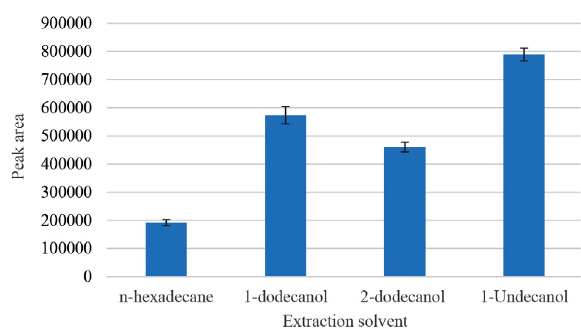
Figure 1. Selection of the extraction solvent used in the microex- traction of morin and quercetin (n =